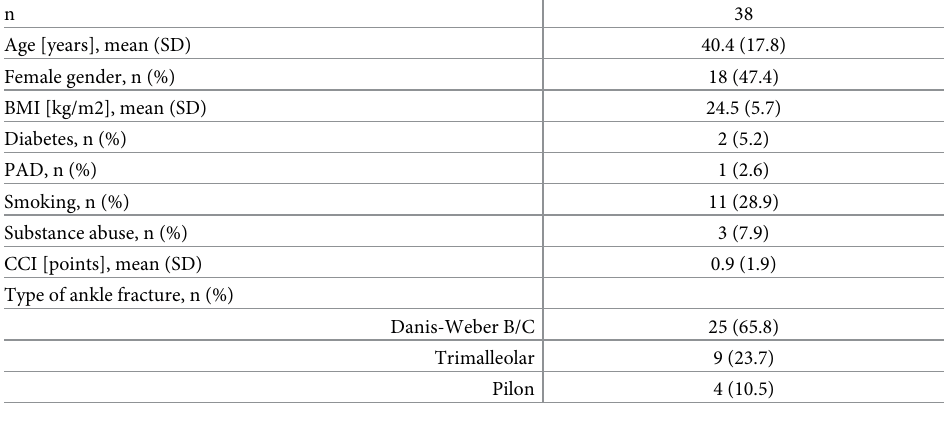
(p = 0.808). The local oxygenation was 3.0% lower in Group DEF (p = 0.08). In Group Temp, the local soft tissue frequency was 20.9% higher than that of patients prepared for definitive treatment (p < 0.001). The soft tissue stiffness was 15.6% higher (p < 0.001), and the stress- relaxation time was 13.3% lower in Group Temp vs Group Def (p = 0.043) (Table 3).